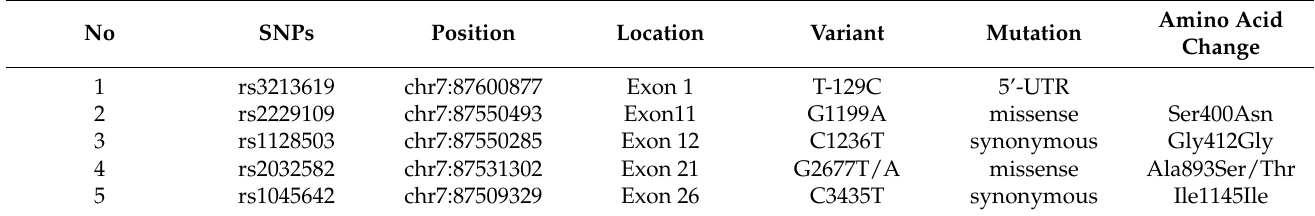
Table 2. ABCB single nucleotide polymorphisms (SNPs) analyzed in this study.